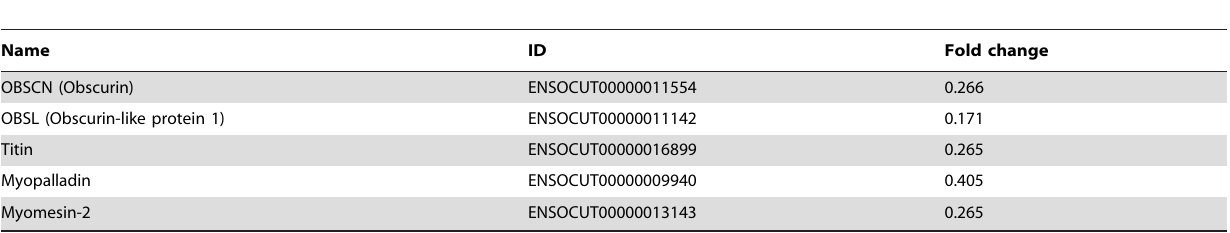
Table 2. Results from most relevant sequences included in M-band functional class identified by FatiScan gene set analysis (M- band (GO: 0031430) block of genes).